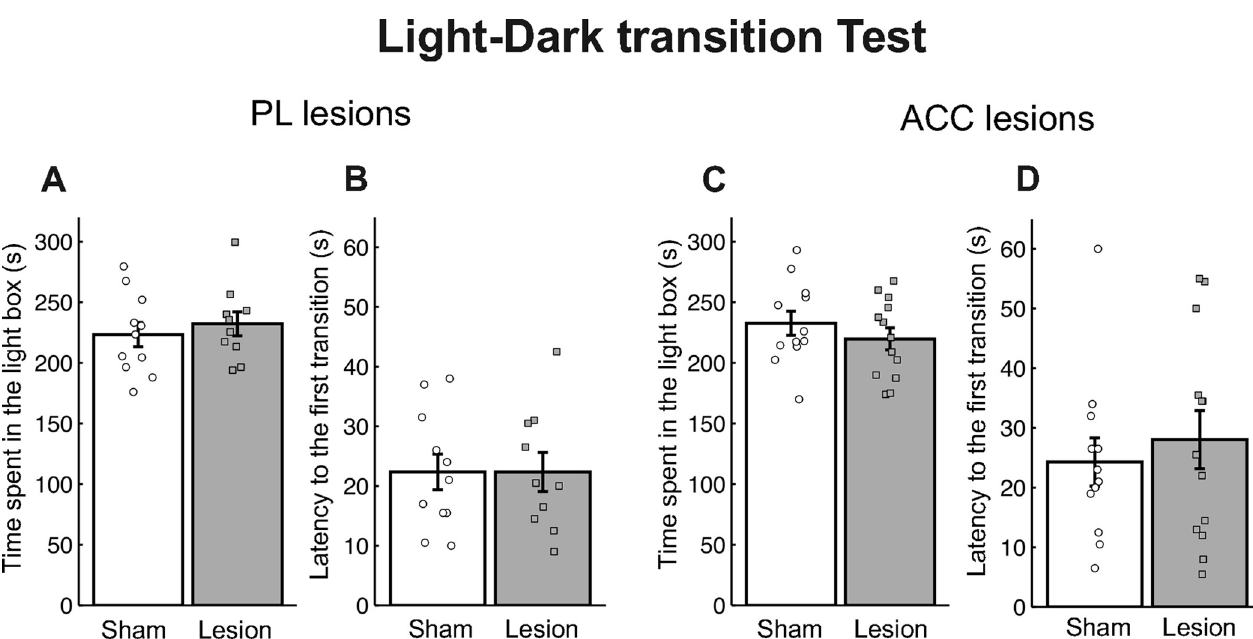
Fig 5. Results of the light-dark transition test in the prelimbic cortex (PL)- (A, B) and anterior cingulate cortex (ACC)- (C, D) lesioned mice. Time spent in the light box (A, C) and latency to the first entry into the light box (B, D). The error bars indicate standard error [PL sham group ( n = 11), PL lesion group ( n = 10), ACC sham group ( n = 12), ACC lesion group ( n =